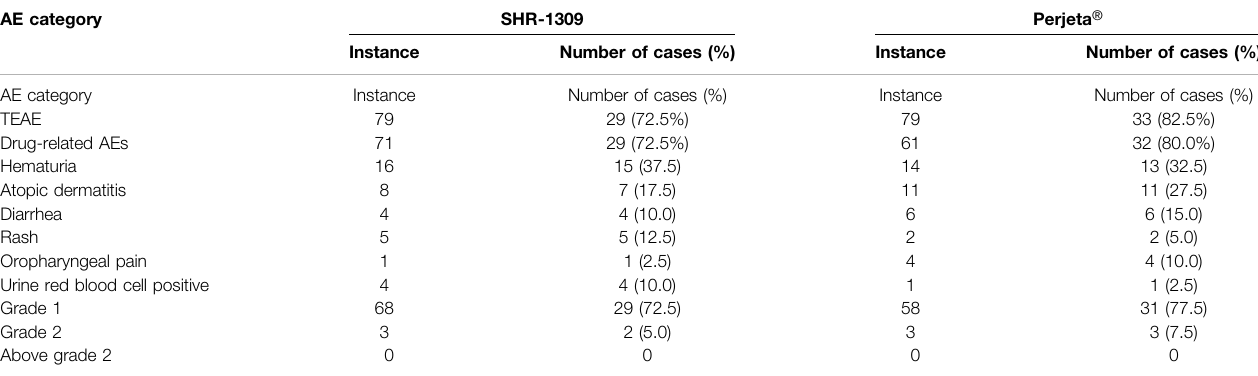
TABLE 5 | Summary of